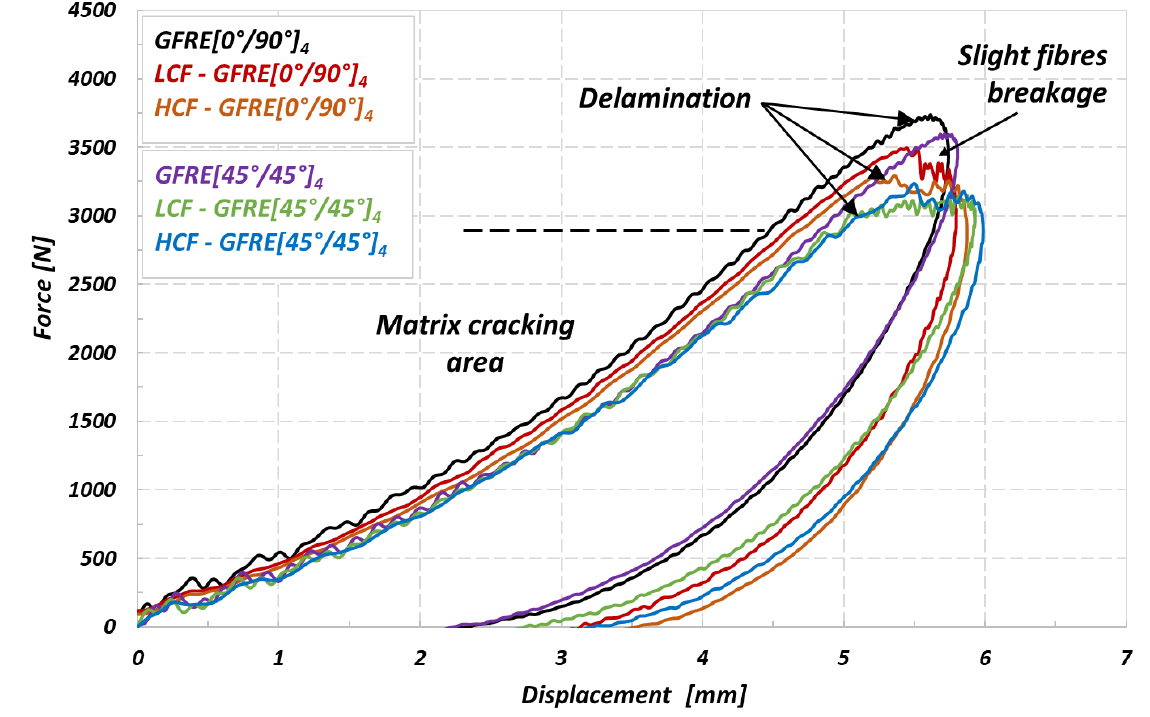
Figure 9. Force–displacement curves of the non-aged and aged GFRE [0 ◦ /90 ◦ ] 4 and GFRE [45 ◦ /45 ◦ ] 4 due to the LCF and Figure 9. Force – displacement curves of the non-aged and aged GFRE [0°/90°] 4 and GFRE [45°/45°] 4 due to the LCF and HCF ageing processes, the results are for an impact energy of 10 HCF ageing processes, the results are for an impact energy of 10 J.